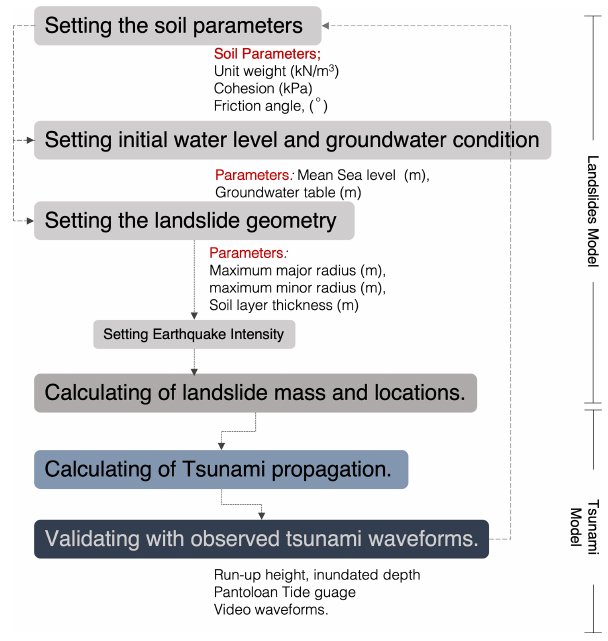
Figure 2. Diagram of modeling